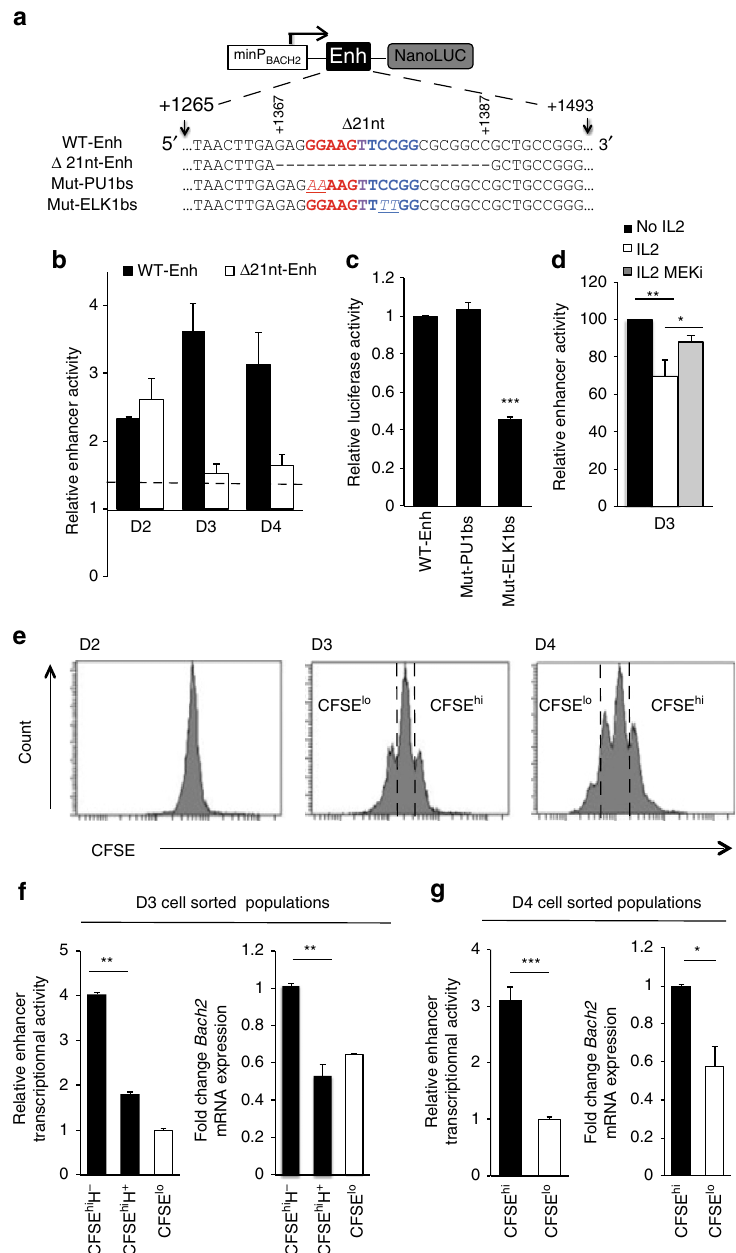
Fig. 9 Role of the ELK1 binding motif in BACH2 enhancer. a ELK1 binding motif (core motif in blue) partially overlaps PU.1 predicted binding motif (core motif in red) within the enhancer of BACH2 intron 1. Positions refer to +1 transcription start site. Deletion of 21 nucleotides from the enhancer ( Δ 21 nt-Enh) or point mutations in the core motifs of PU1 binding site (Mut-PU1bs) or ELK1 binding site (Mut-ELK1bs) are underlined. b Luciferase activity of activated naive B cells electroporated with the wild-type enhancer (WT-Enh) or the enhancer deleted of 21 nucleotides ( Δ 21 nt-Enh), at different time points (D1, D2 and D3) and cultured for 24 h. Luciferase activity is presented relative to the cells electroporated with the BACH2 promoter (minP BACH2 ) alone (activity fi xed to 1 for the different time points). Statistically signi fi cant cutoff value (dotted line) was obtained by adding 2 standard deviations to the mean value obtained for the promoter activity alone. c Luciferase activity measured at D3, 24 h after electroporation of reporter construct that carries the wild-type enhancer sequence (WT-Enh) and the derivative plasmids with mutations in PU1 core motif (Mut-PU1bs) or ELK1 core motif (Mut-ELK1bs). Luciferase activity is presented relative to the activity of the WT-Enh. ( n = 3, mean ± s.e.m., *** p < 0.001, two-tailed unpaired Student ’ s t -test). d Effect of IL-2 stimulation on the enhancer activity. Activated B cells were electroporated on D2 with the WT enhancer reporter construct and then stimulated (IL2) or not (No IL2) with IL-2 for 24 h in presence of MEK inhibitor (MEKi) or DMSO. Enhancer activity ( fi xed to 100 for the No IL2 condition) was determined relative to luciferase activity of the BACH2 promoter alone. ( n = 6, mean ± s.e.m., ** p = 0.007, two-tailed unpaired Student ’ s t -test). e Kinetic of CFSE pro fi les. f Enhancer activity measured by luciferase assay and BACH2 gene expression level at D3 in f and D4 in g , in cell-sorted populations based on CFSE dilution from gates in e (CFSE hi/lo ), and cell cycle: Hoechst positive (H + ) vs. Hoechst negative (H − ). Data are representative of three independent experiments (means ± s.e.m., * p < 0.05, ** p < 0.01, *** p < 0.005, two-tailed unpaired Student ’ s t